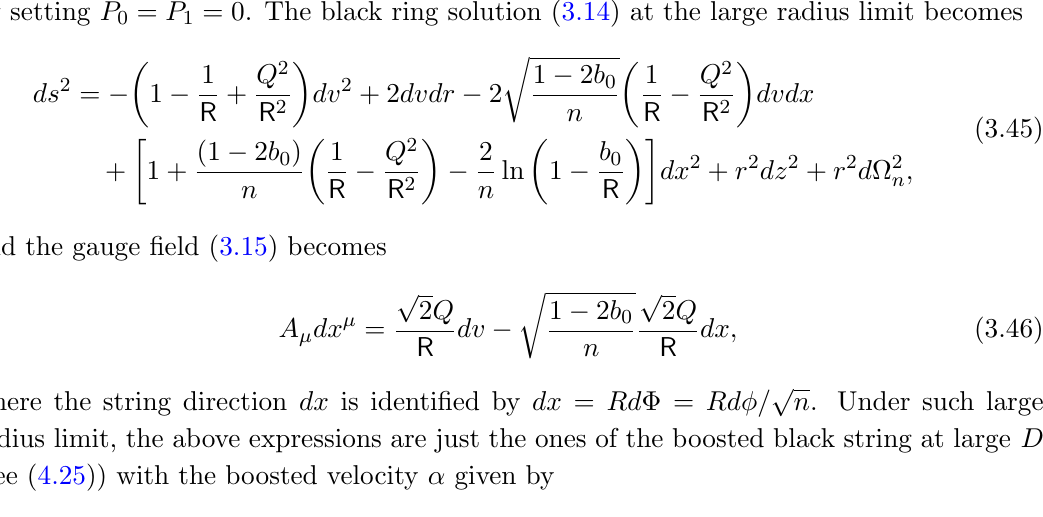
Figure 4 . Dependence of Im[ ! ( ‘ =0) m = 2 and R = 1 =